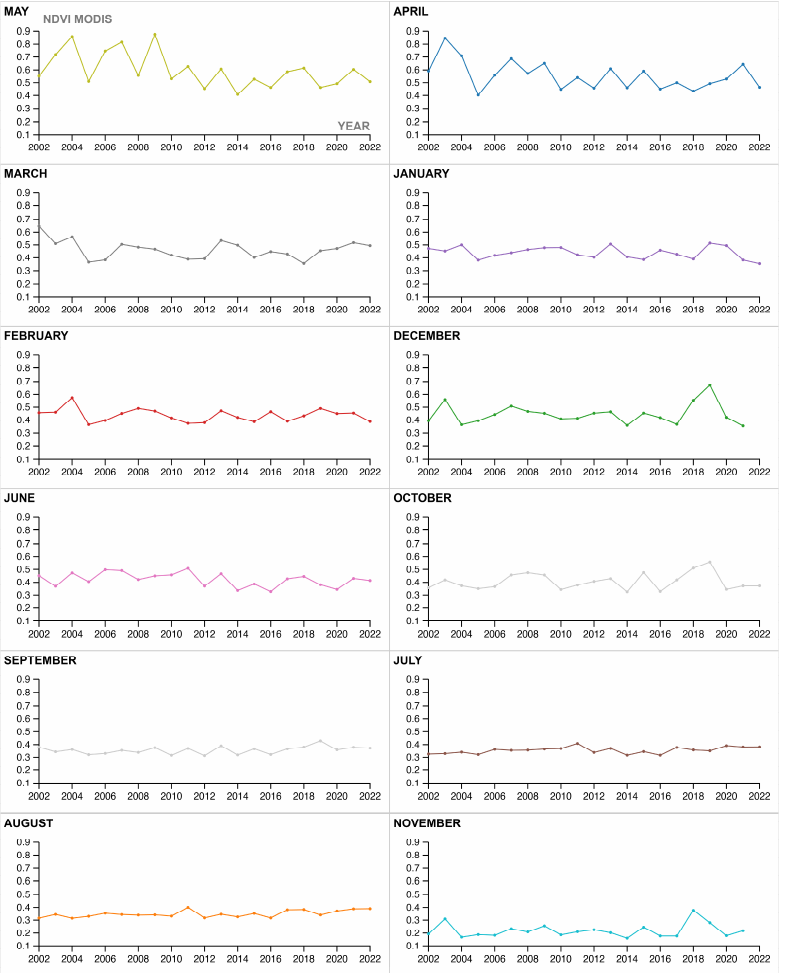
Figure 9. MODIS/006/MOD13Q1 NDVI vegetation trends monthly-phenological growth rate—the highest registered amplitude in the NDVI profile is registered at the start of the growing season (SOS) during March and April (germination) and the end of the growing season (EOS) in May (maturity). Moreover, it is to consider the interesting fact that the actions in place are contributing to the overall resilience of the ecosystem during the Winter Season (WS) months, from December to February.